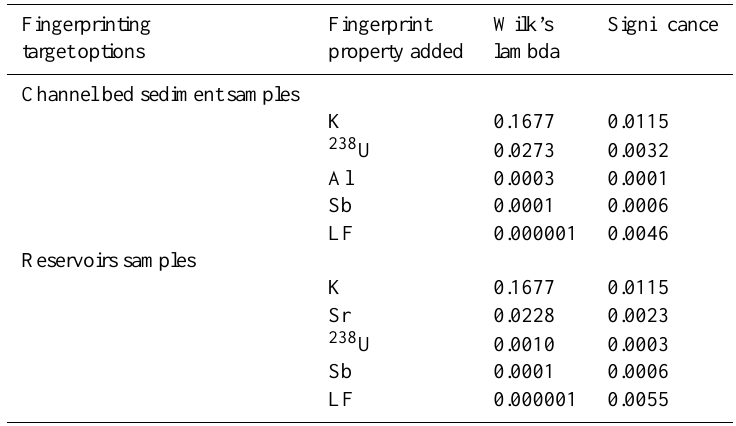
Table 4. Results of the stepwise discriminant function analysis to identify the optimum composite fingerprint for the assessed fingerprinting options.